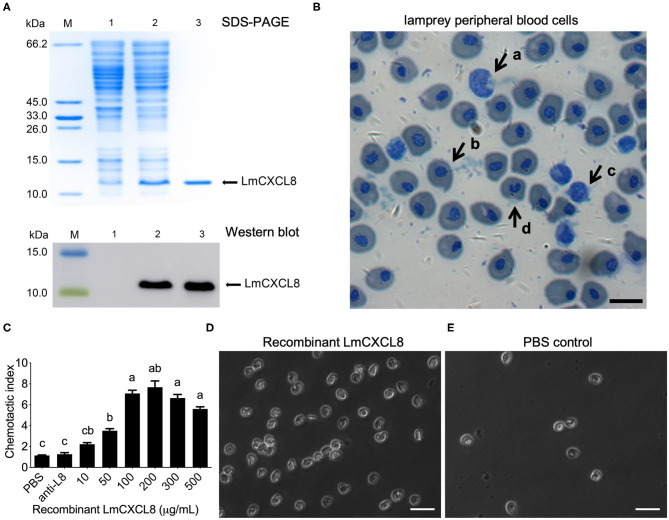
Recombinant LmCXCL8 induces chemotaxis in lamprey leukocytes. (A) Sodium dodecyl sulfate–PAGE and Western blot analysis of recombinant LmCXCL8 protein. M: protein molecular weight marker. Lane 1: induced pColdI/BL21 (as a control); Lane 2: induced pColdI-CXCL8/BL21; Lane 3: purified recombinant LmCXCL8 protein. (B) Microscopic structures of the lamprey peripheral blood cells (×400). Wright-stained smear showing the lamprey peripheral blood cells. The scale bar is 10 μm. (a) Monocytes, (b) erythrocyte, (c) lymphocyte, (d) neutrophil. (C)
In vitro chemotaxis of lamprey leukocytes to recombinant LmCXCL8. Brown–Forsythe and Welch ANOVA test, p < 0.0001; lowercase letters above each bar denote statistical results from Dunnett T3 multiple-comparisons test: the bars sharing the same letter represent means that are not different from each other (p > 0.05), whereas the bars labeled with different letters indicate means that are different (p < 0.05). One hundred microliters of PBS was used as a negative control. Anti-L8, anti-CXCL8 antibody-blocking treatment for 4 h. Data indicate the mean ± SEM from three lampreys pooled from three independent experiments. (D)
In vitro chemotaxis of lamprey leukocytes that migrated into lower chamber contains recombinant CXCL8 protein (200 μg/mL). The scale bar is 20 μm. (E)
In vitro chemotaxis of lamprey leukocytes that migrate into lower chamber contains phosphate-buffered saline (PBS). The scale bar is 20 μm.